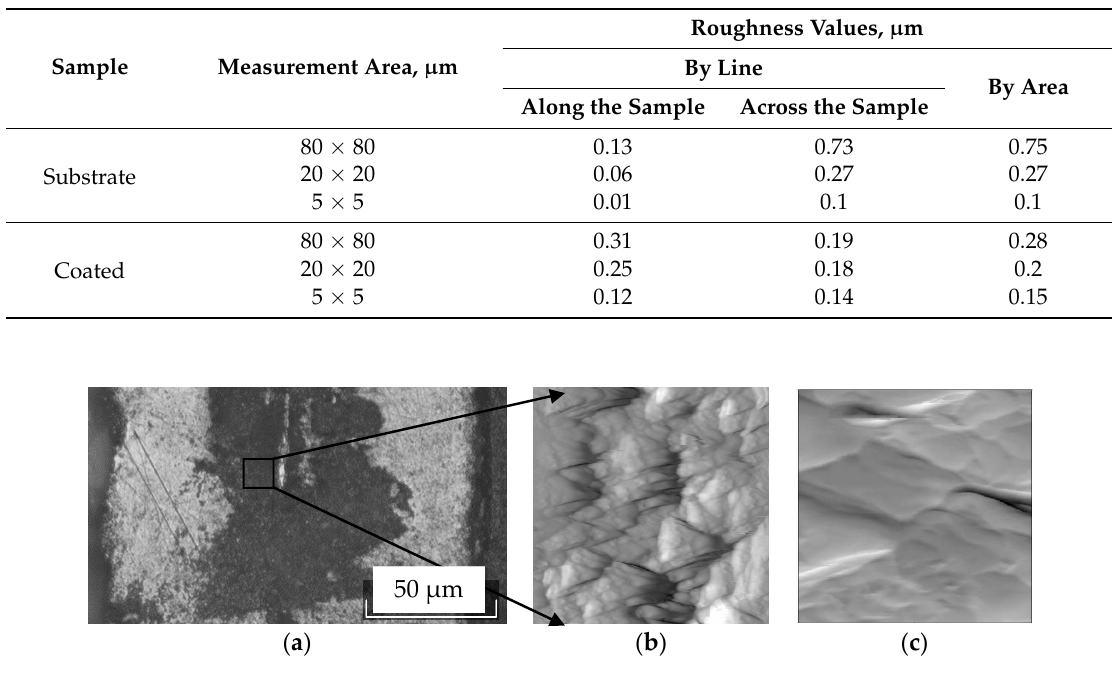
Figure 3. Microimage of the original molybdenum plate cross-section after etching: ( a ) optical